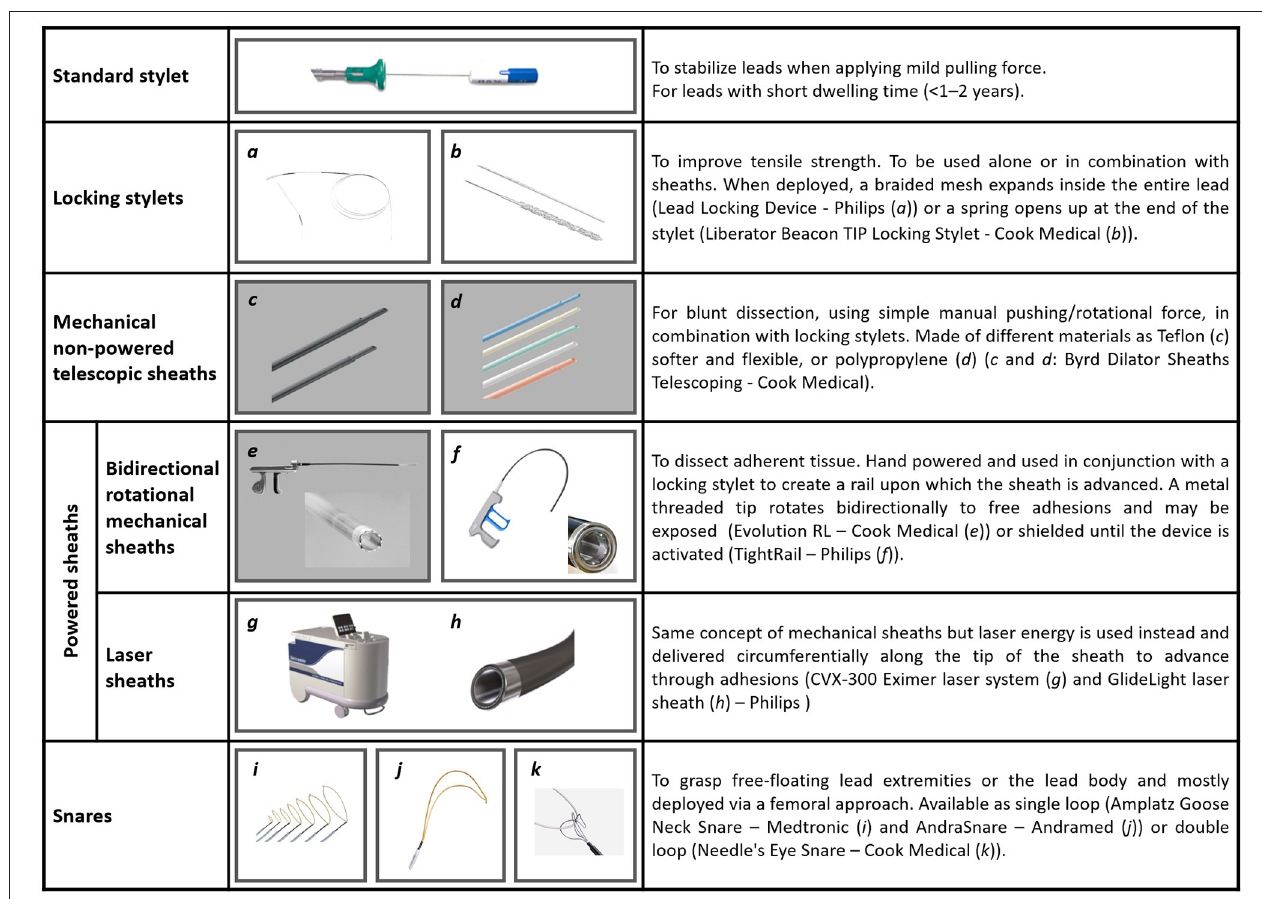
FIGURE 2 | Tools and techniques currently in use to perform percutaneous TLEs [Figure text adapted from Bongiorni et al. (1) and from (41)].